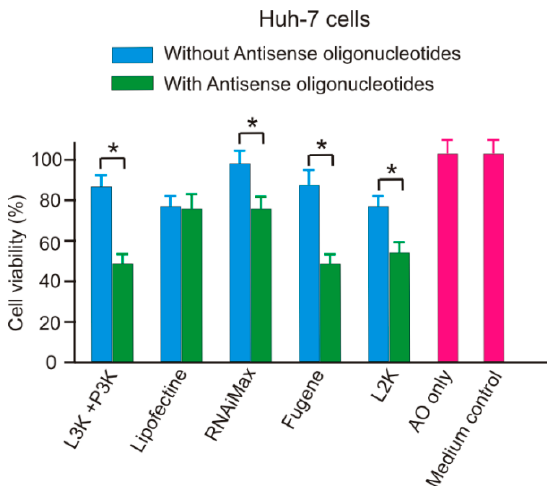
Figure 14. Addition of ASO significantly increase the cytotoxicity of transfection reagents in Huh-7 cells. L3K: Lipofectamine 3000; P3K: P3000, L2K: Lipofectamine 2000. * p < 0.01.